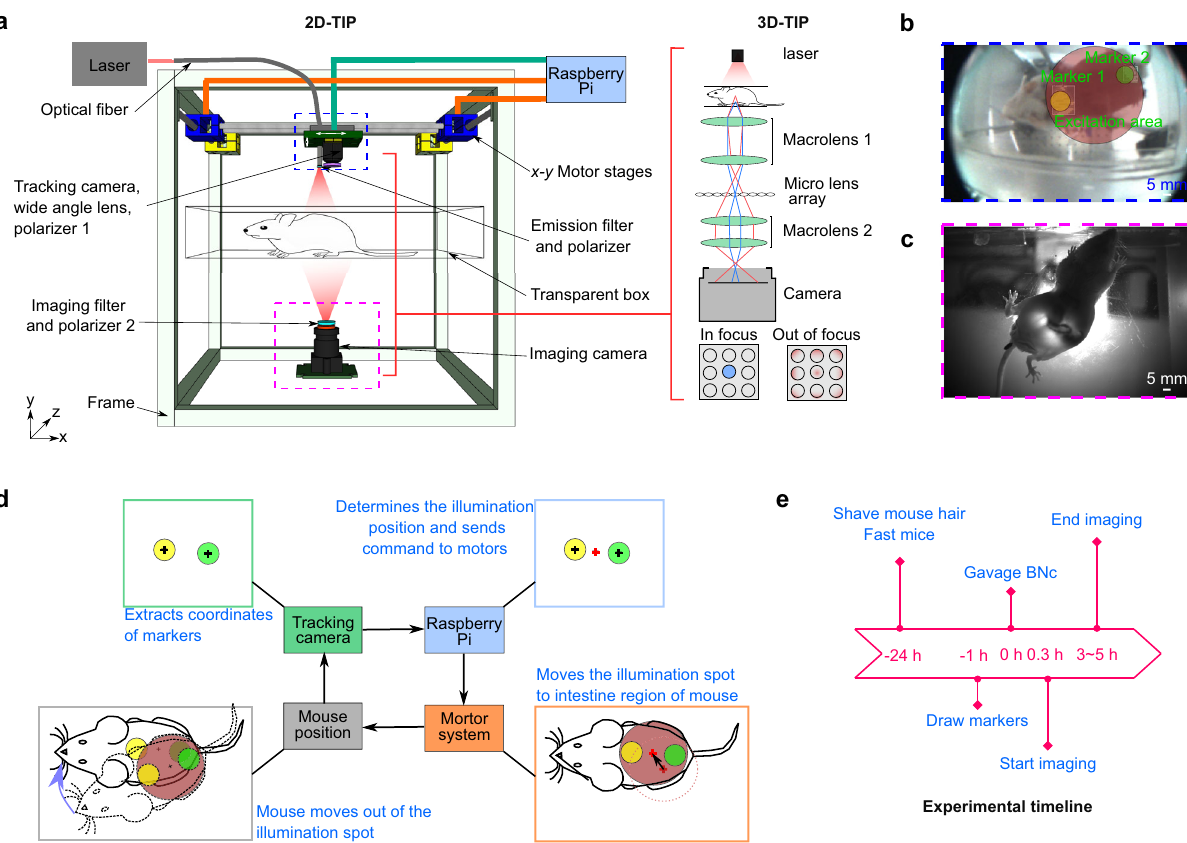
Fig. 1 TIP imaging system. a A schematic drawing of the 2D-TIP system that is capable of imaging free-moving mice. The inset on the right illustrates the schematic of 3D-TIP, which is capable of imaging volumetric intestine. The microlens array captures 4D light- fi eld information. When the point source is located at the principal focal plane (blue), it will be imaged by only one microlens (bottom left); when the point is located out of the principal focal plane (red), it will be imaged by multiple microlenses (bottom right). The light- fi eld information allows for 3D image reconstruction. b An exemplary image acquired by the tracking camera in 2D-TIP. c An exemplary image acquired by the bottom NIR camera. d A diagram illustrating the closed-loop control of the tracking system. e The experimental